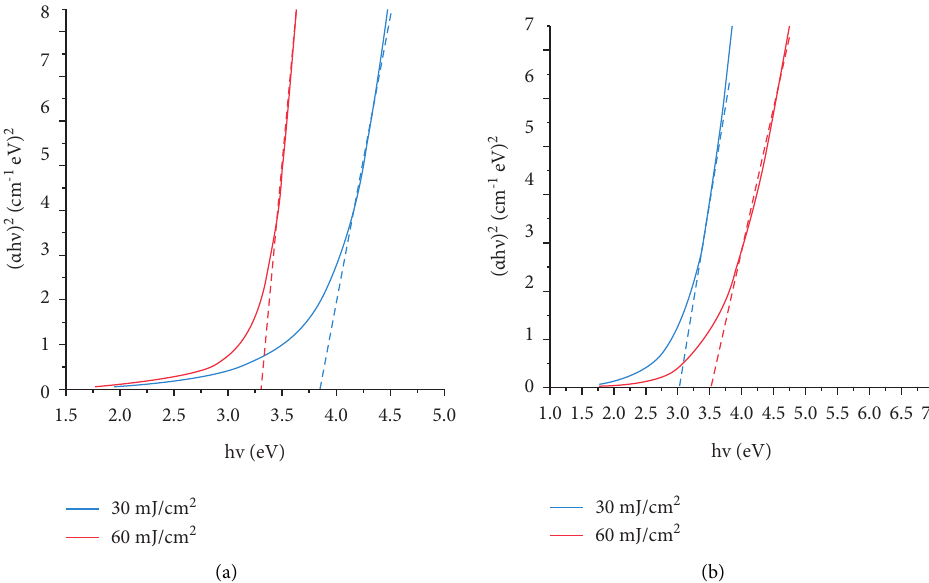
Figure 7: The ( α h ] ) 2 versus photon energy plot of the NPs prepared by LASER ablation in liquid medium with a LASER fluence of 30 mJ/ cm 2 and 60mJ/cm 2 : (a) without the presence of the magnetic field and (b) with the presence of the magnetic field.